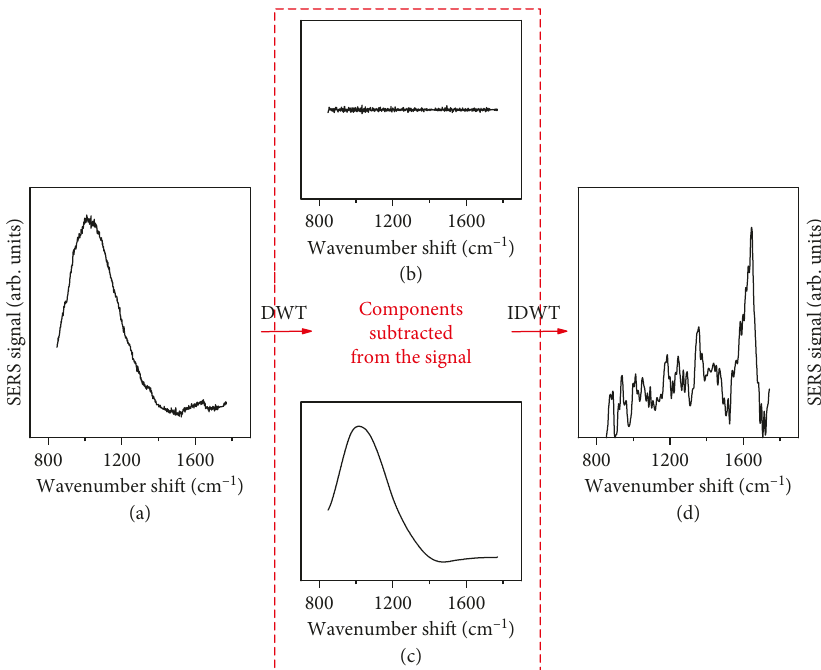
Figure 1: Schematic description of the data elaboration procedure based on the wavelet algorithm. The measured spectrum of an olive oil sample is reported in (a) panel. The signal exhibits a strong fluorescence signal centred at 1017cm 675nm. Using direct wavelet transform (DWT) algorithm, the signal has been decomposed in components at different scales. The signal has been reconstructed by excluding high-scaled ((b) panel) and low-scaled ((c) panel) components. The resulting signal is shown in (d) panel.